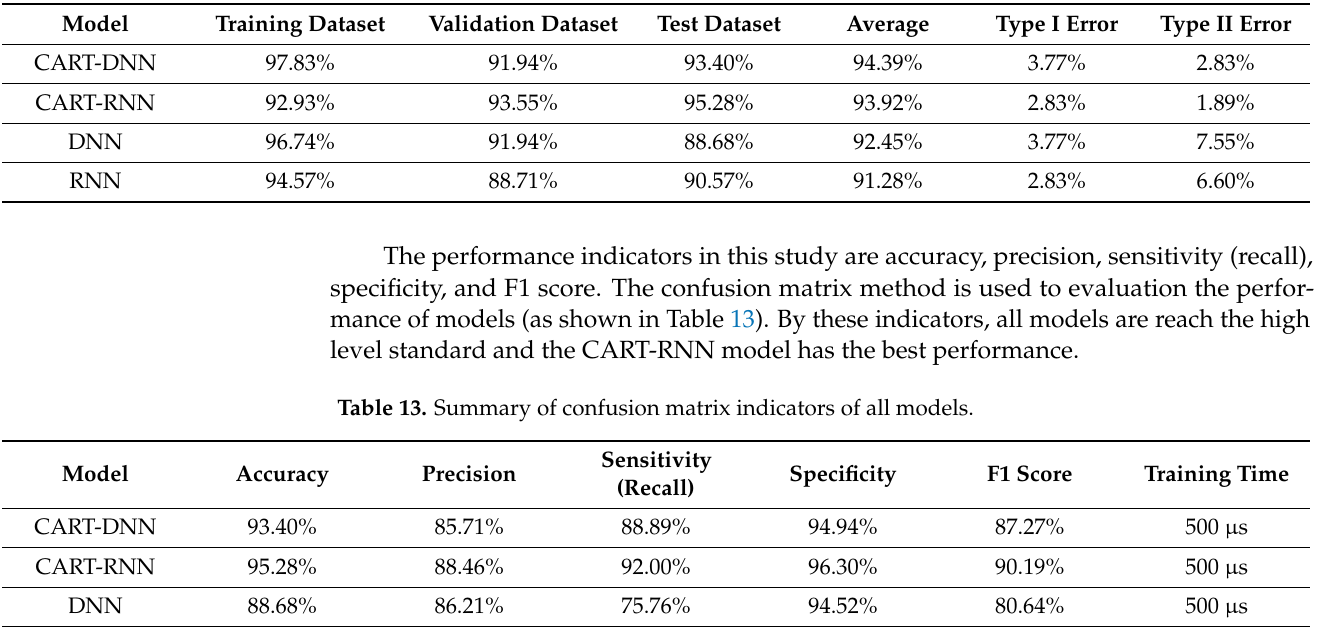
Table 12. Summary of accuracy of all models.